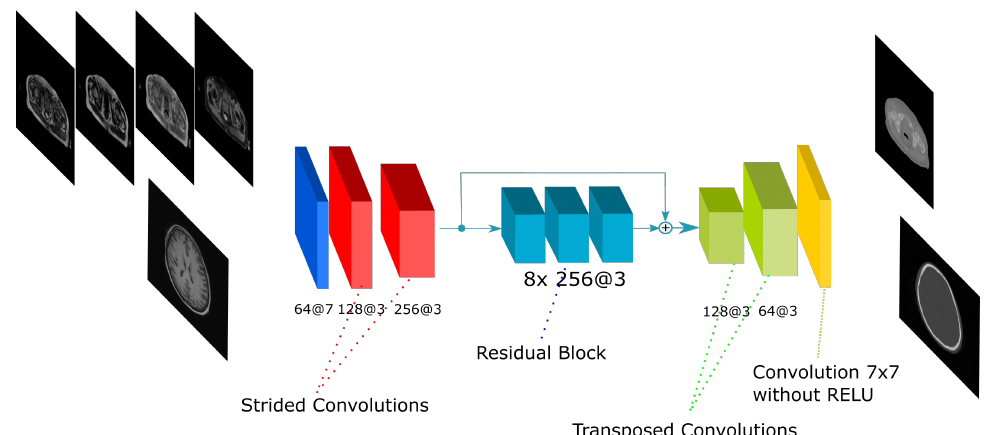
Figure 5. Residual-Net architecture. The scheme shows the CNN architecture including the residual blocks in between the encoding and the decoding steps. The network receives either the four Dixon- VIBE MR sequences of the pelvis or the T1-weighted image of the brain as input. Then, it outputs a pelvis or a head pseudo-CT,